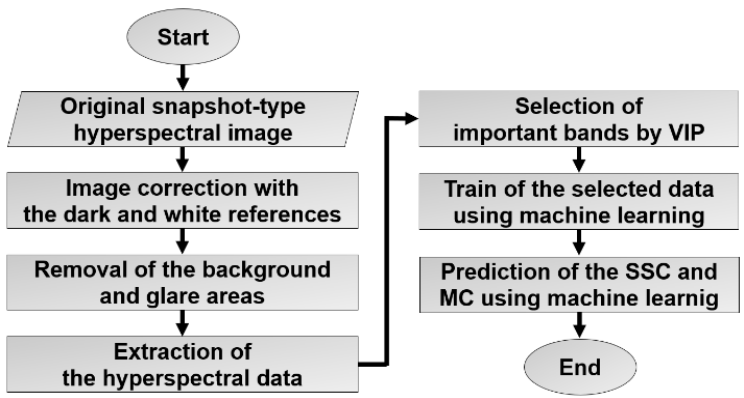
Figure 3. Flowchart diagram for predicting the SSC and MC in oriental melons from the snapshot-type hyperspectral image.